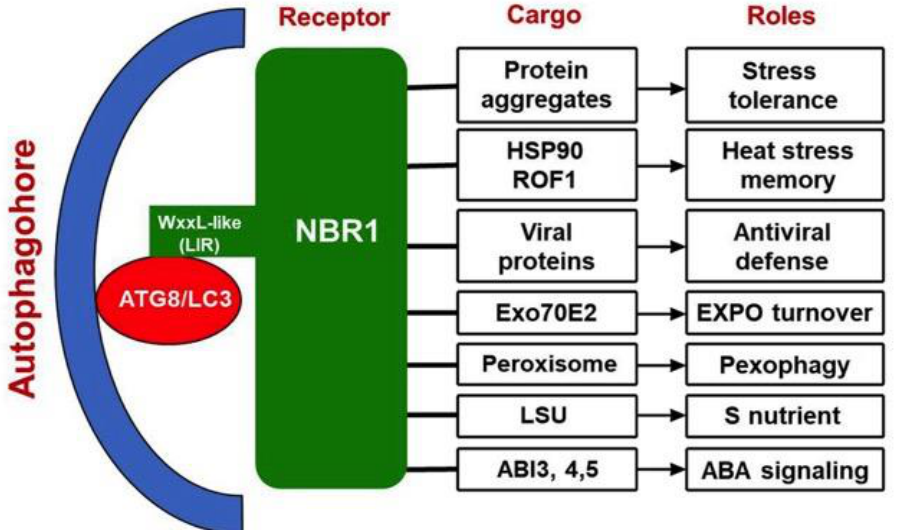
Figure 2. NBR1-mediated selective autophagy in plant stress responses. The cargo proteins and biological roles of NBR1 in aggrephagy, heat stress memory, antiviral defense and Exo70E2 are well supported by biochemical, molecular and genetic evidence. Studies through analysis of protein localization, gene expression, protein-protein interactions and transgenic overexpression have also suggested possible roles of NBR1 in stress-induced pexophagy, S nutrient response and ABA signaling.